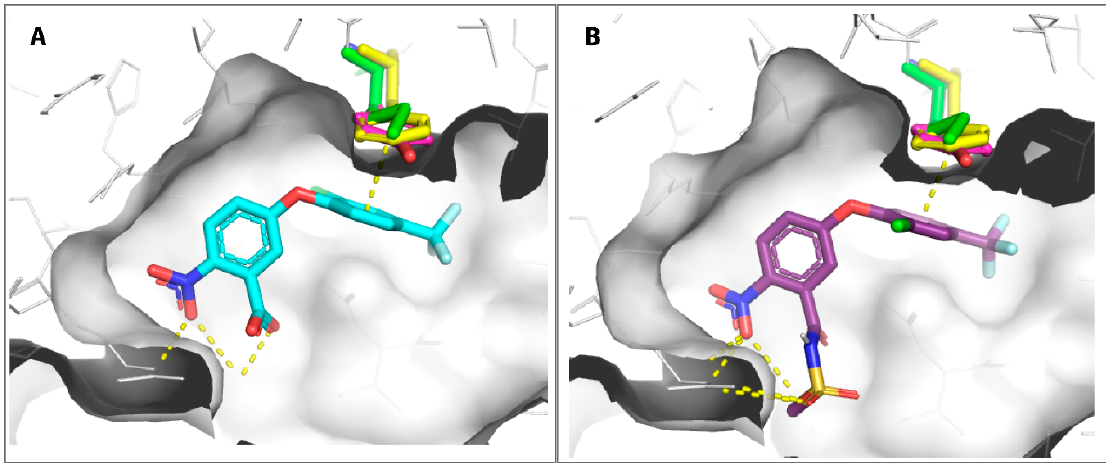
Figure 6. Methionine substitution is linked to the lower potency of herbicides against hPPO. The hPPO binding pocket shown in grey representation ( A ) co-crystallized with acifluorfen (stick representation, cyan carbon atoms) and ( B ) docked with fomesafen (stick representation, violet carbon atoms). hPPO Met-368 is highlighted by green sticks. The atPPO and ntPPO structures were superimposed onto hPPO, but only the corresponding Tyr (stick representation, magenta carbon atoms) and Phe (stick representation, yellow carbon atoms) are highlighted.